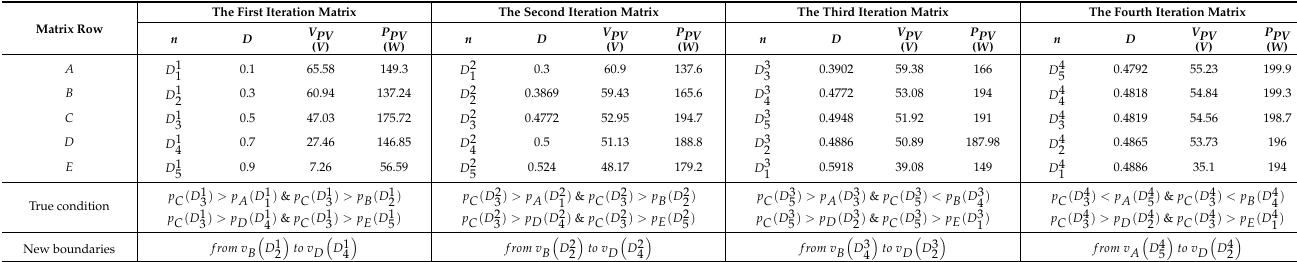
Figure 11. The GMPP tracking method for pattern-4. ( a ) The samples’ operating points at the first four iterations. ( b ) The tracking performance by using CSA. ( c ) The tracking performance by using ICSA. Table 8. The rearranged and saved data for pattern-4.